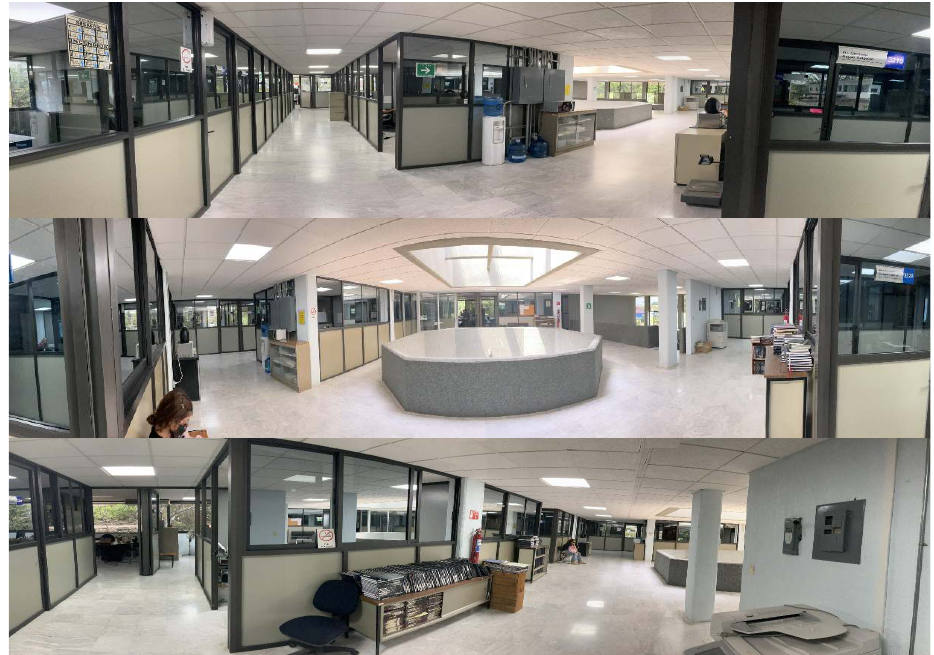
Figure 7. Real navigation environment.